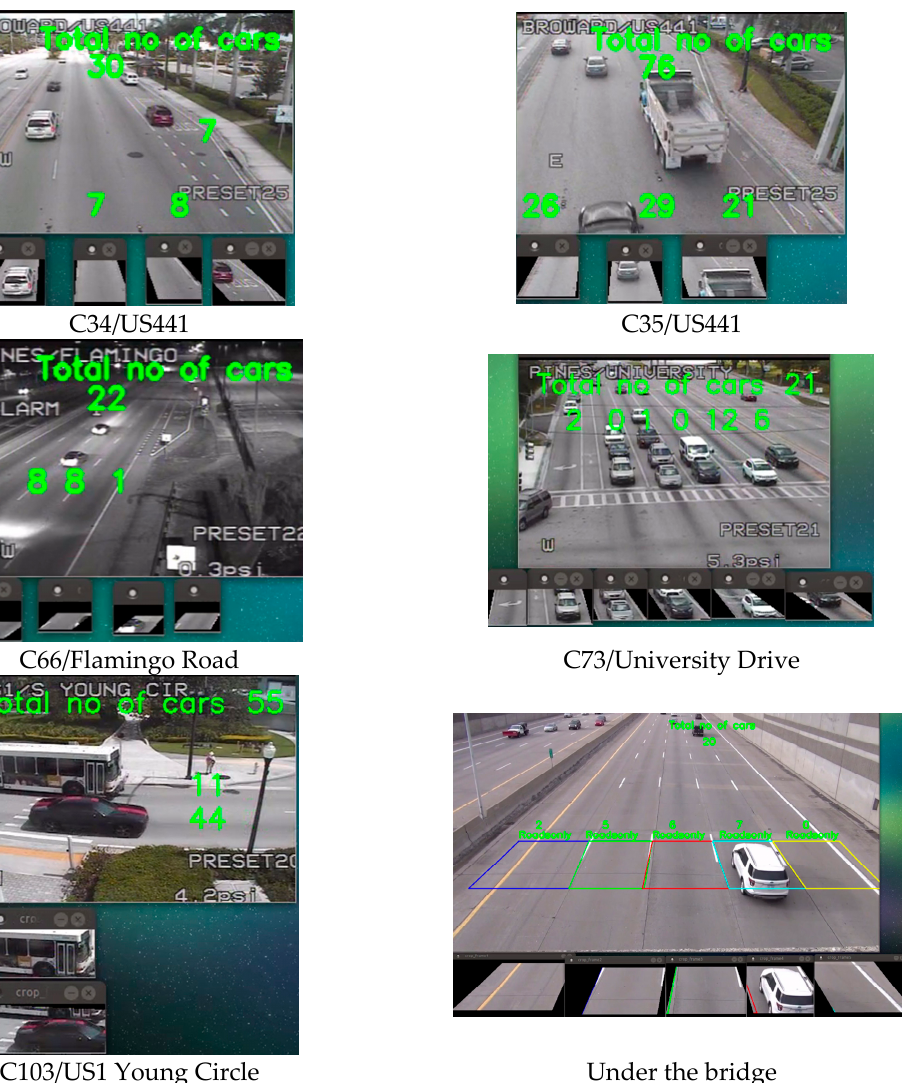
Figure 8. OverFeat network results.